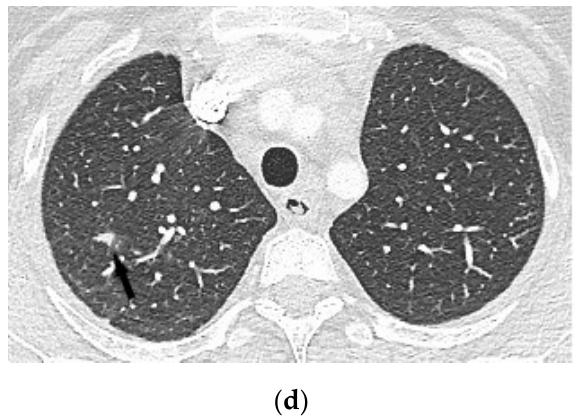
Figure 2. Chest CT scan with contrast enhancement: mediastinal window ( a , b ) and lung window ( c , d ) revealed large pericardial effusion up to 4 cm thick ( a , b , asterisk), with no significant pericardial thickening, and SVC and IVC dilatation. A small amount of pleural fluid was also demonstrated. Additionally, several small nodules were seen in the apex of the right lung ( c , d , arrows). Echocardiography showed a large amount of fluid in the pericardial sac (up to 25 mm in diastole), localised mostly behind the posterior and lateral walls of the left ventricle, with no signs of cardiac tamponade or pericardial constriction.